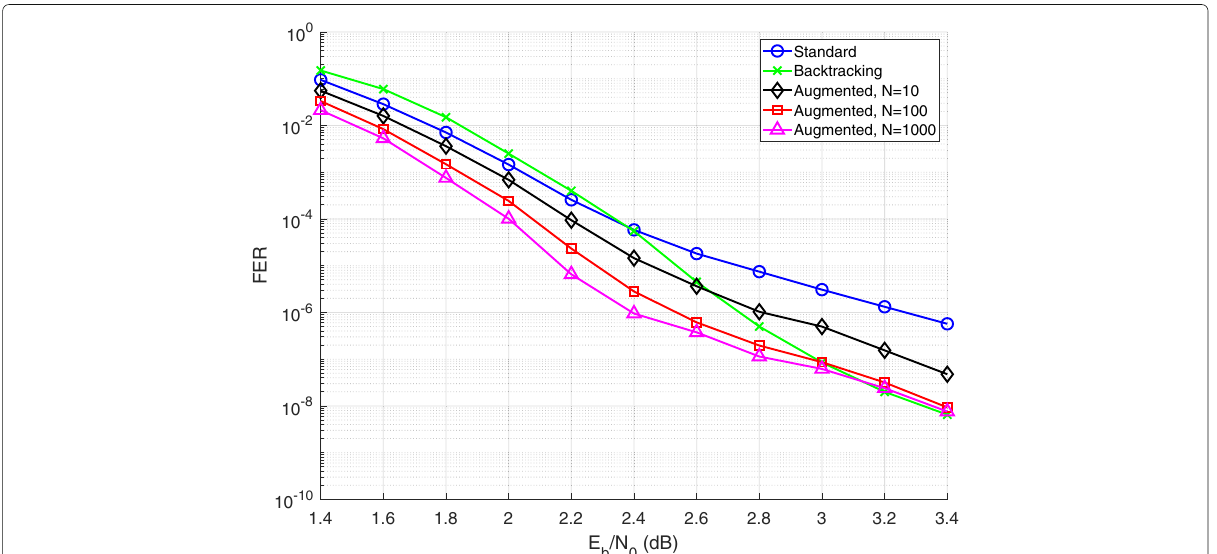
Fig. 6 n = 1056 WiMAX FER plot. FER performance of augmented decoders for the n = 1056 and R = 1 / 2 WiMAX code. Also shown is the performance of a backtracking decoder